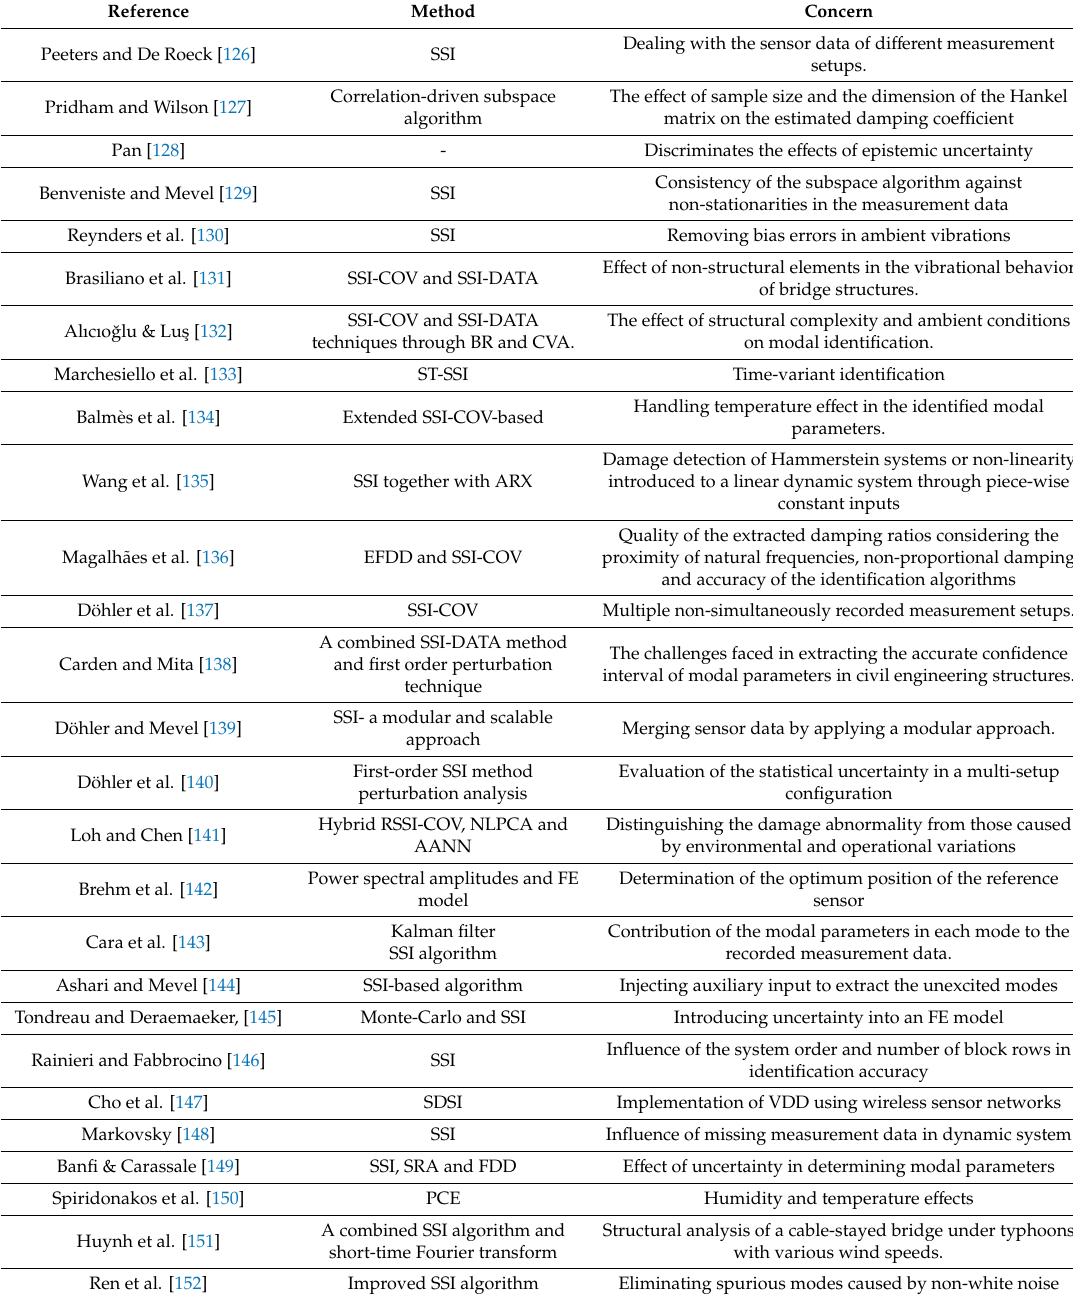
Table 6. The challenges of SSI in practical